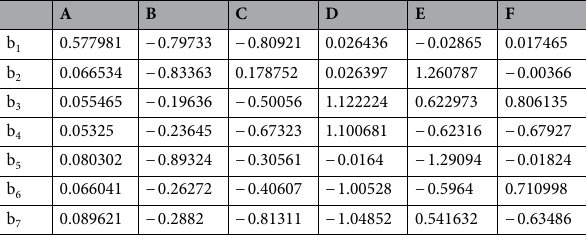
Table 1. Coefficients of pressure velocity parameterization